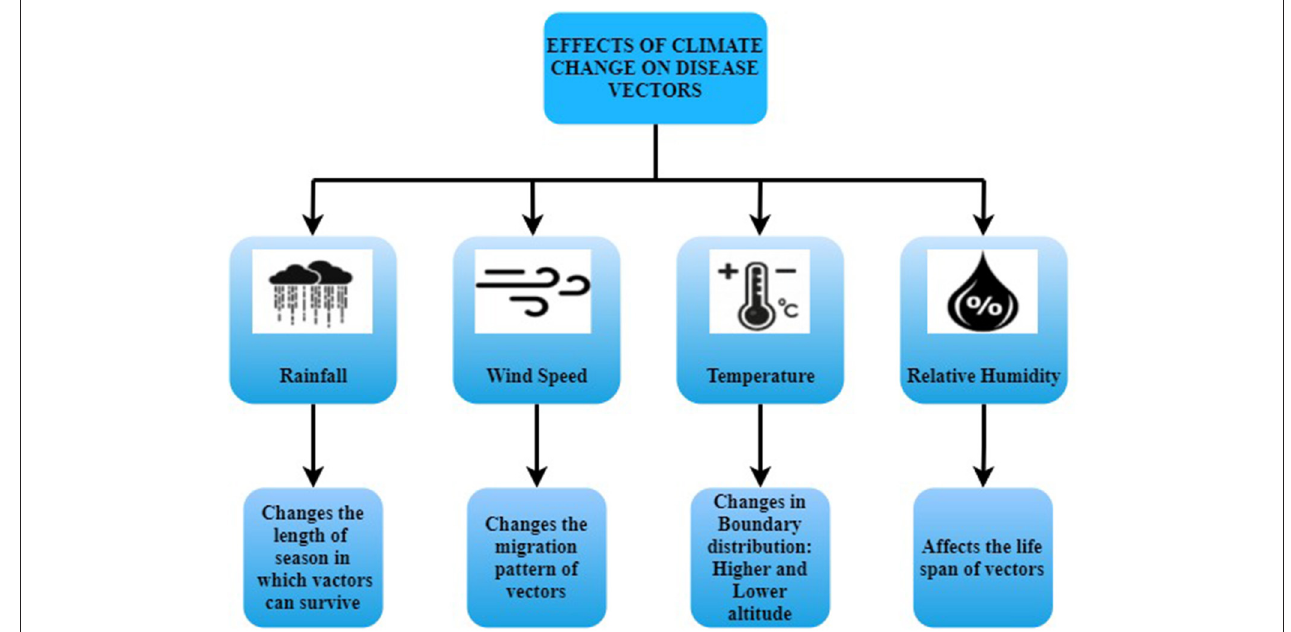
FIGURE 2 | Schematic overview of the proposed